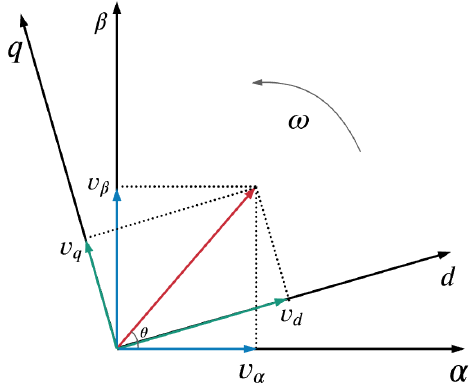
Figure 3. Park and Clarke transformations [29].